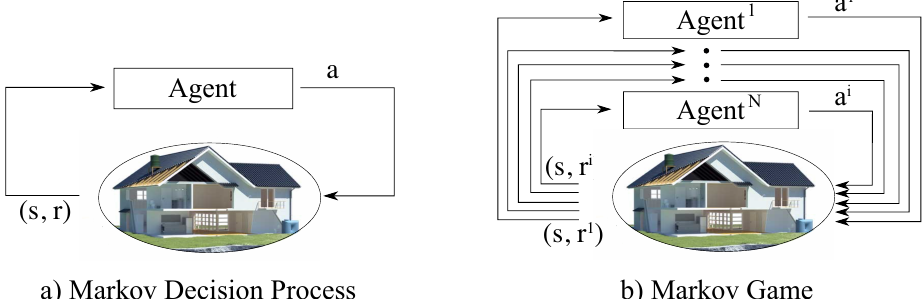
Figure 1. Illustration of the difference between a Markov Decision Process and a Markov Game. In ( a ) one agent and one environment are seen. The agent interacts with the environment by sending a tubule of actions and receiving one reward and the states of the environment. In ( b ) multiple agents and one environment are seen. The action space is split into i number of actions. Each agent receives a reward and the states of the